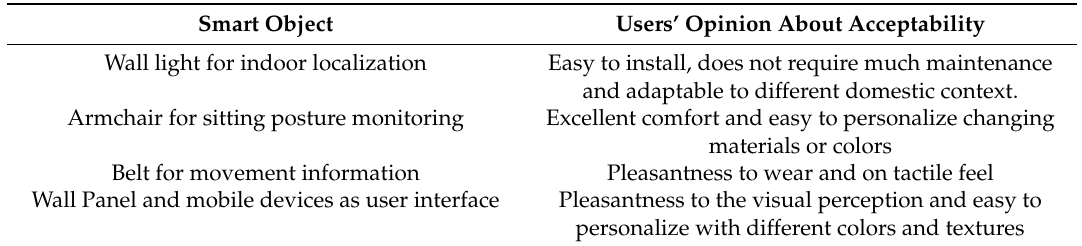
Table 1. Users’ opinion about acceptability of each devices, collected during the interviews. Smart